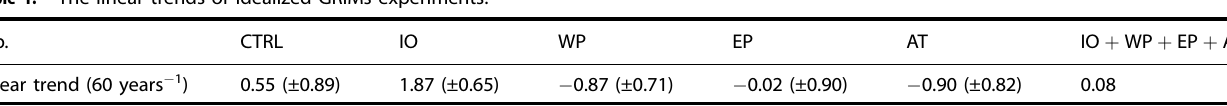
Table 1. The linear trends of idealized GRIMs experiments.